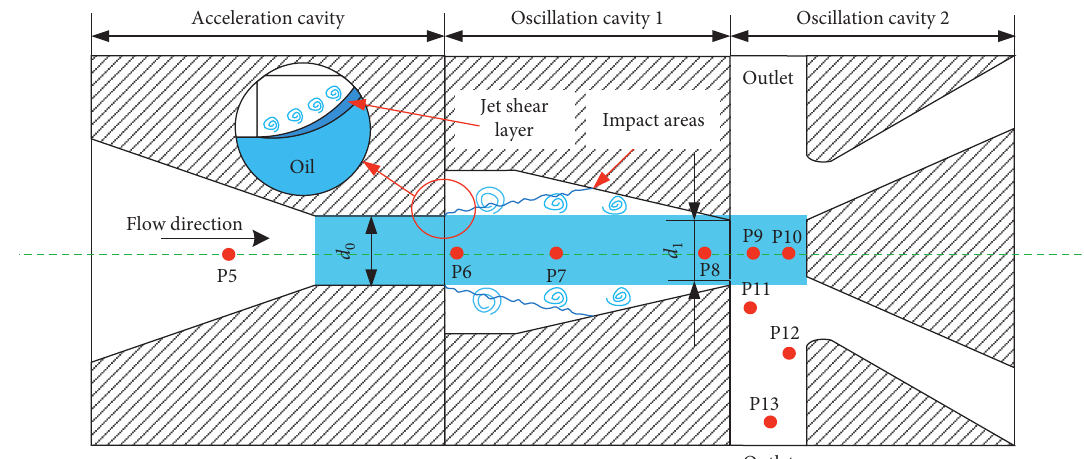
Figure 21: Prestage oscillation cavity based on the Helmholtz oscillator